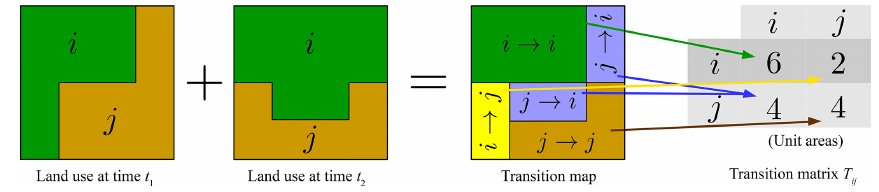
Figure 2. Illustration of the geometric union operation that combines the information of two land-cover maps into a transition map and how the transition matrices are obtained from this